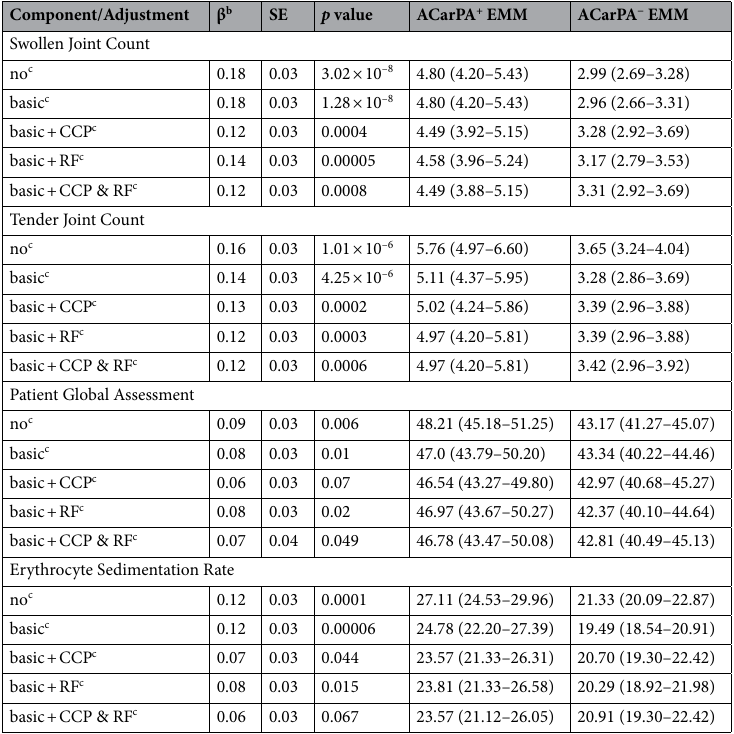
Table 3. DAS28-ESR components in the ACarPA + patients relative to the ACarPA − EA patients at baseline a . a Data from 978 EA patients were analyzed in the first row of each component and 99% of them in the remaining rows. b Results are presented as in the Table 2. c The analyses were performed as in the Table 2 except that sqr(SJC), sqr(TJC) and ln(ESR) transformations were used in the general linear regression. EMM and their 95% CI corresponding to these three measures were back-transformed for